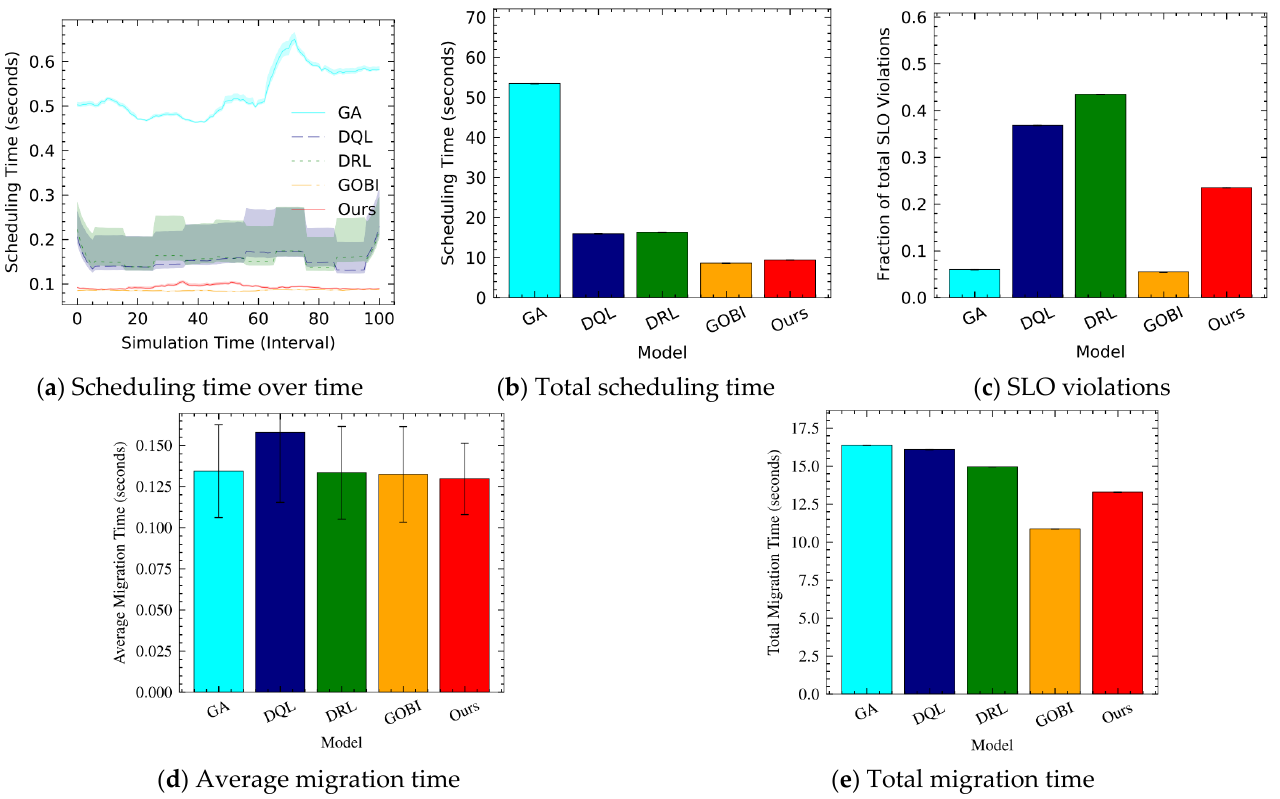
Figure 2. Mini-test experiments with six hosts.